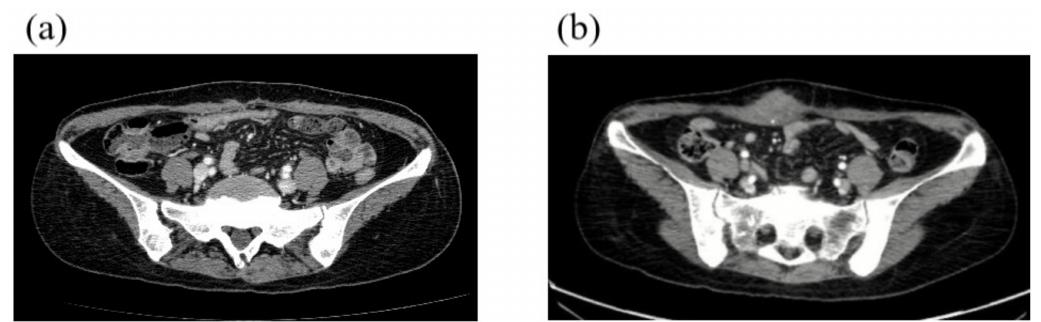
Figure 4. Imaging of patient No 1. in 2019. ( a ) Computed tomography (CT) scan of the pelvis showed a metastatic lesion in the rectus muscle in January 2019. ( b ) The metastatic lesion in the rectus muscle had increased in size by March